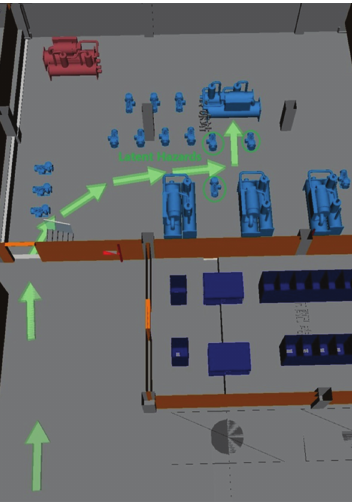
Figure 7: Traditional travelling path and latent